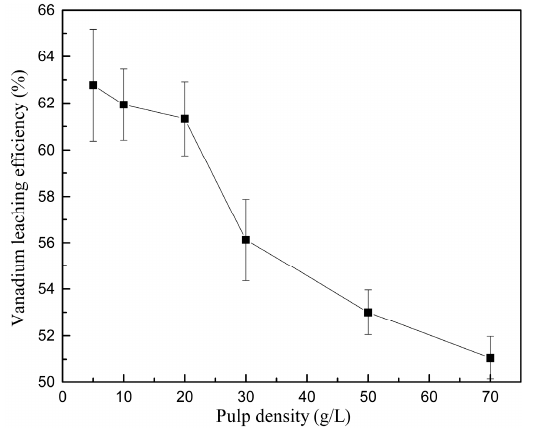
Figure 4. The highest vanadium leaching efficiency over time at different pulp densities.